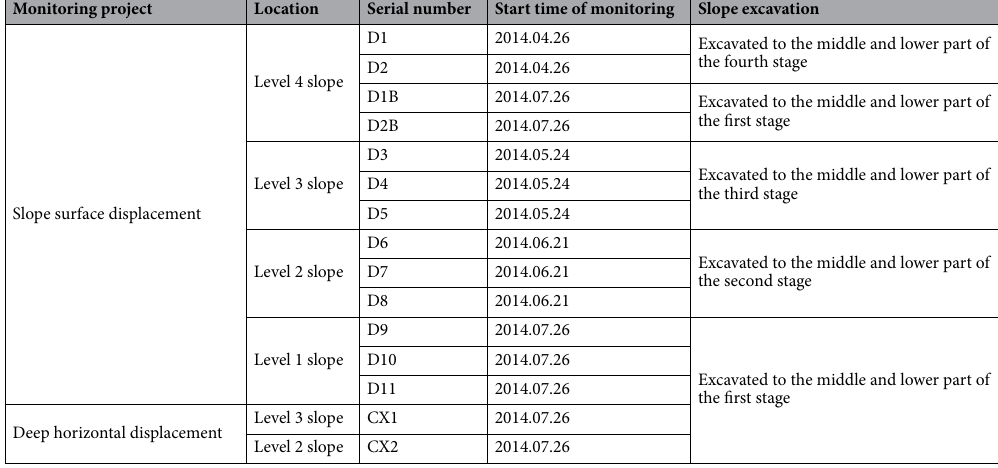
Table 1. Monitoring point layout time.